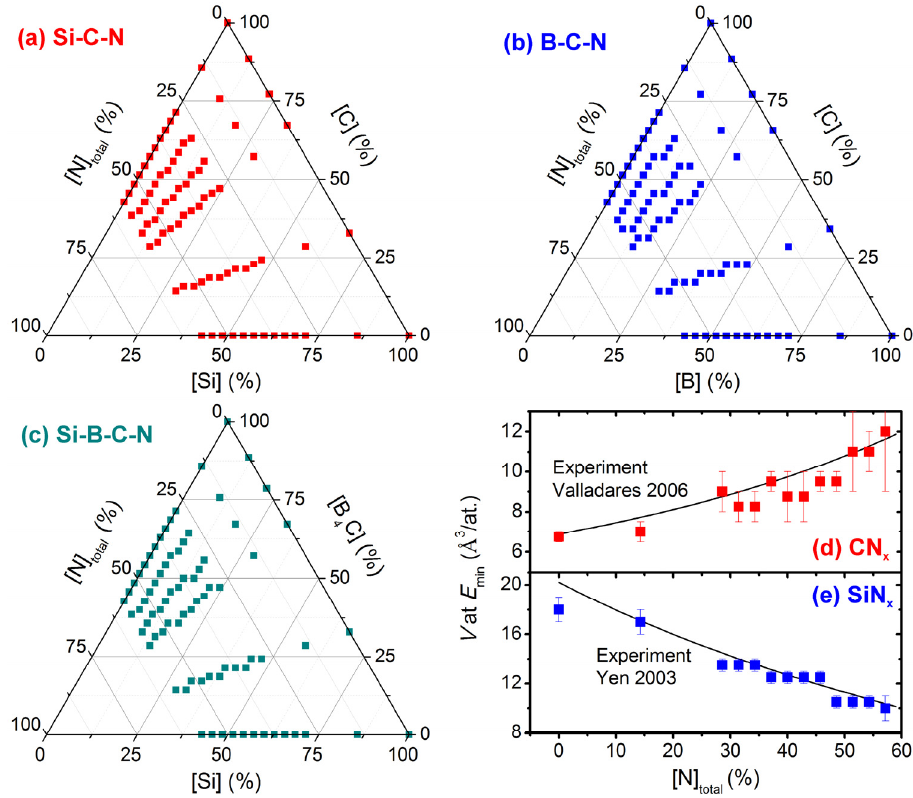
Figure 1. Panels ( a – c ) show the compositions simulated. There are 16 different [Si]/[B]/[C] ratios (18 lines of datapoints including SiN x and CN x which are shown in two panels) and 13 [N] total values at each of these ratios. Some of the lines corresponding to B-containing compositions are more noisy because of keeping even number of electrons in the simulation cell. Panels ( d , e ) constitute a verification of the simulation technique and of the algorithm which allows the atoms to form unbonded N 2 . The datapoints show calculated lowest-energy inverse atomic density ( V ) of CN x (panel ( d )) and SiN x (panel ( e )) [41]. The black lines are fits to experimental densities of CN x (Equation (1) [37]) and SiN x (Equation (2) [45]). The error bars (mainly due to limited simulation cell size) represent the smallest intervals of V values which include simulations leading to (i) the two lowest energies and (ii) all other energies within 20 meV/at. from E min , if there are any. 2.3. Reliability of the Simulation Protocol While the LQ algorithm in itself is well established, it is worth discussing the deci- sion to allow the N atoms to form unbonded N 2 molecules which are not instantly lost to the atmosphere. Figure 1d,e show lowest-energy V of CN x and SiN x (binary systems chosen because of the availability of corresponding experimental data) predicted using the described simulation protocol in a wide [N] total range. The calculated V is compared with measured V (converted from mass density, ρ , using the Avogadro number, N A , and the molar masses, M Si,C,N ): ρ CNx (g/cm 3 ) = 2.897 − 0.01784 × [N] total (fit on experimental data by authors of [37]) ⇔ V CNx (Å 3 /at.) = {M C ×(100 − [N] total ) + M N ×[N] total )}/{(2.897 − 0.01784 × [N] total ) × N A × 10 − 22 }